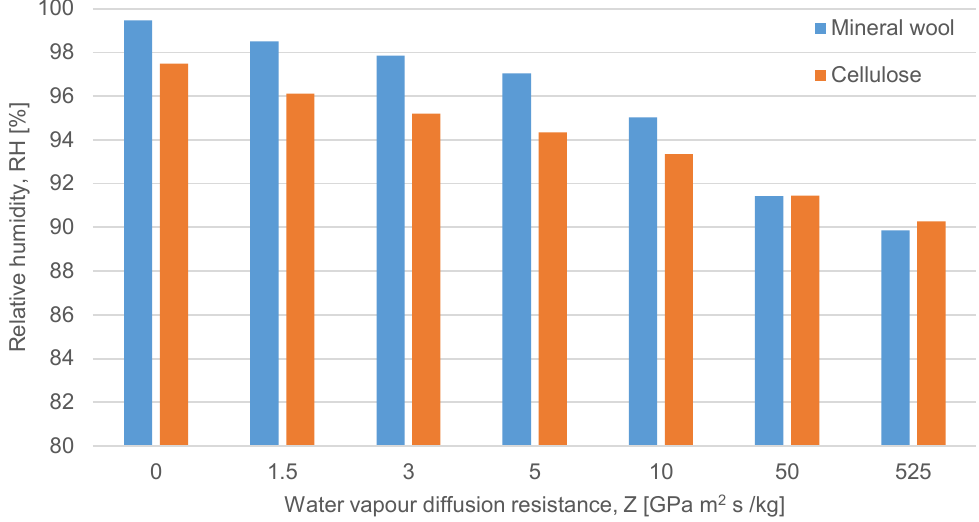
Figure 3. Maximum relative humidity in point A for internal humidity class 3. Figures 4 and 5 show the temperature and relative humidity at point A, for simulation year six, for internal humidity class 3. The temperature is for the wall design with a vapour barrier with a water vapour diffusion resistance (Z p ) of 5 GPa m 2 s/kg, and the relative humidity is presented for each vapour barrier and the critical relative humidity. The critical relative humidity is calculated from the temperature according to [21].